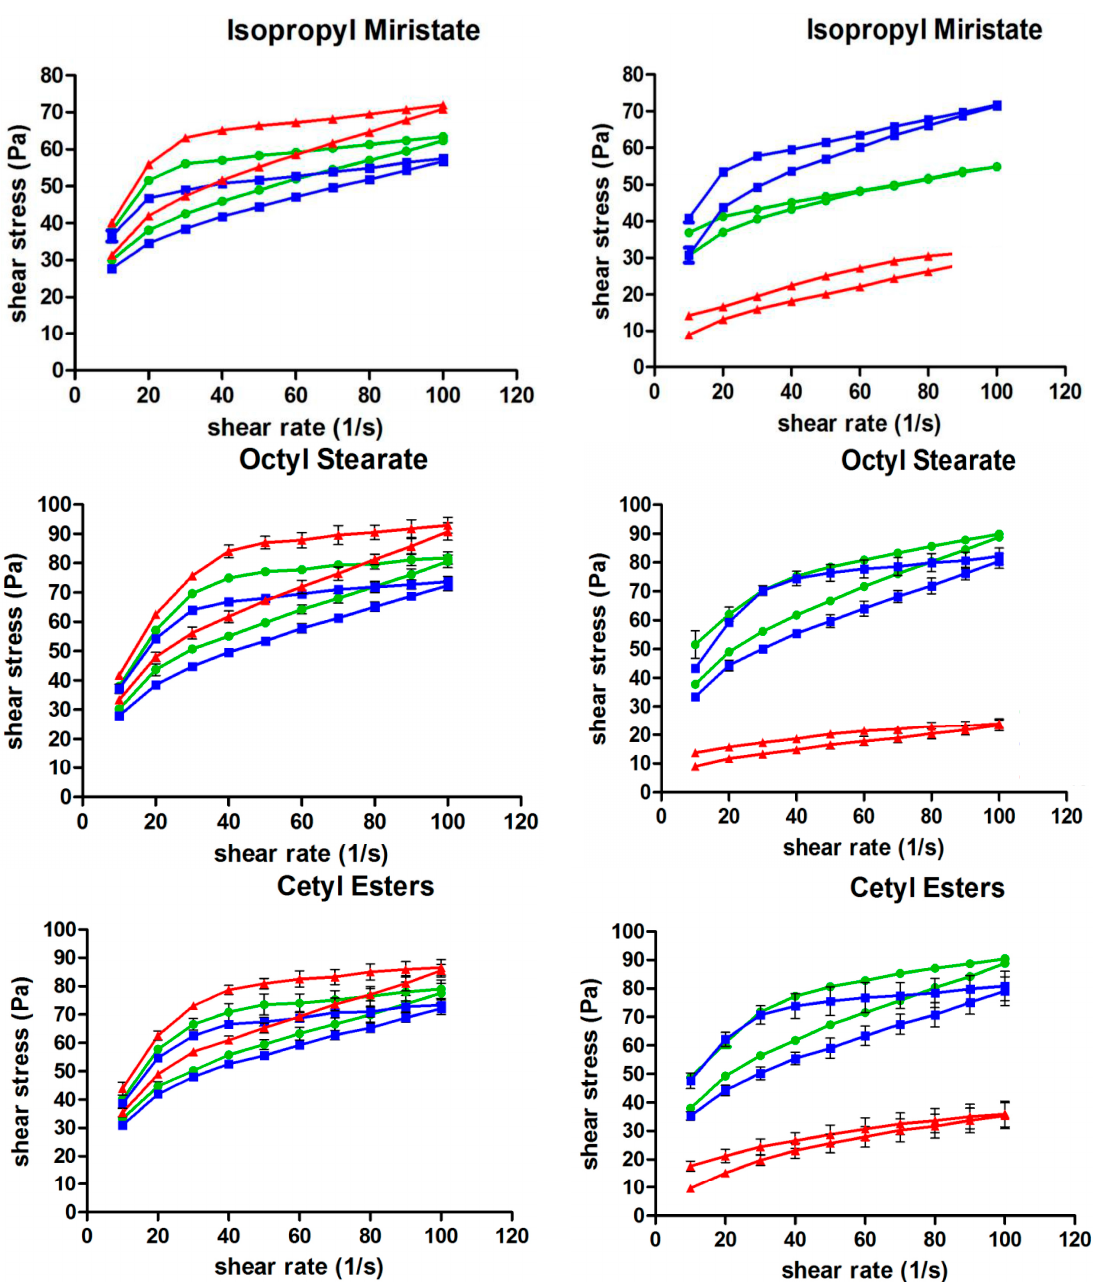
Figure 7. Behavior of emulsions subjected to different stored conditions according to time ( n =